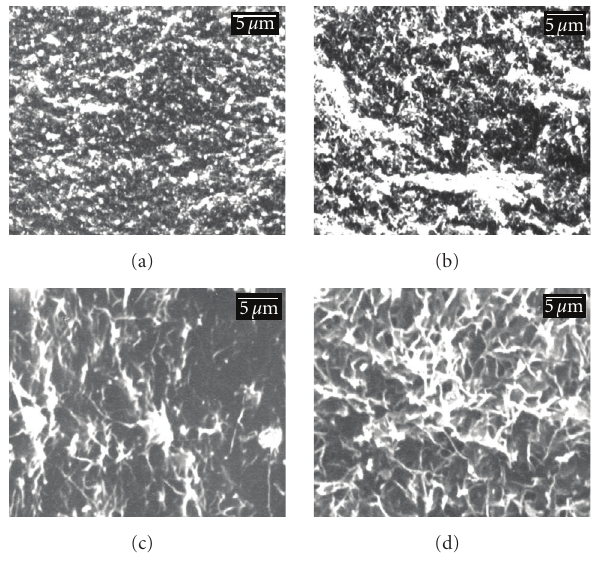
Figure 4: SEM micrographs of HAp/CSP nanocomposite samples with various contents of n-HAp particles (a) 20% (w/w), (b) 30% (w/w), (c) 40% (w/w), and (d) 50%